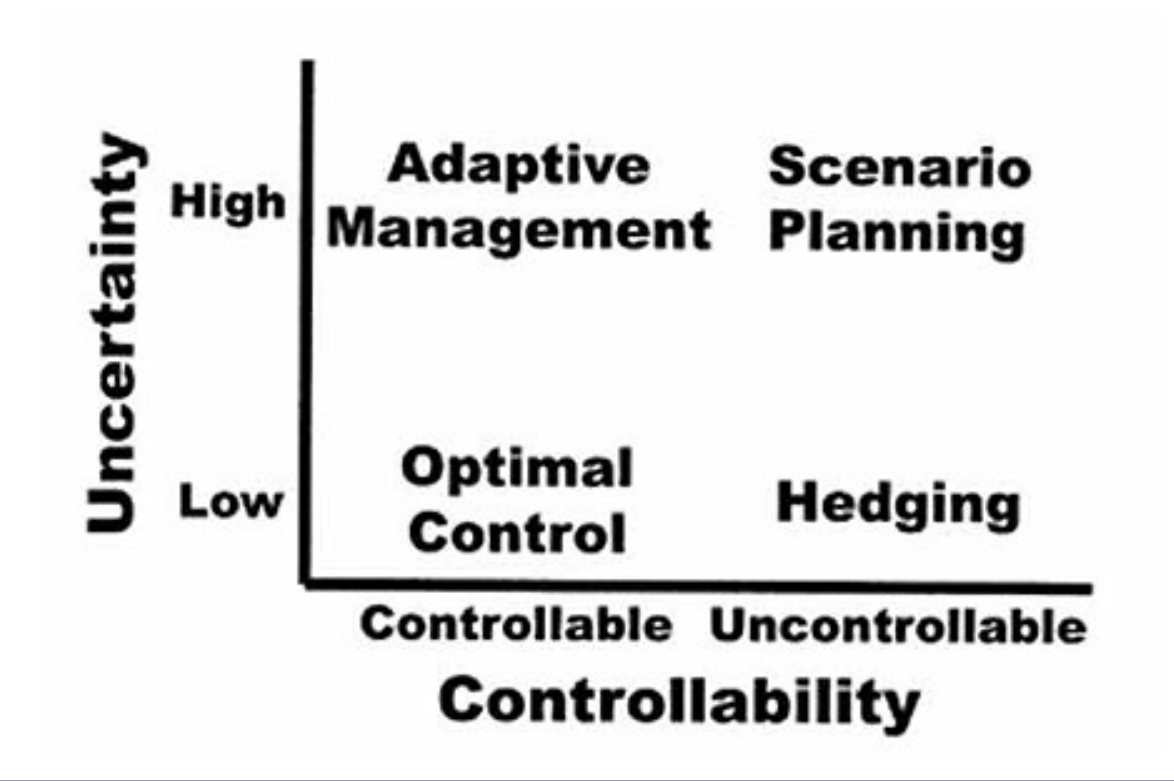
Fig. 1 . Scenario planning is most appropriate under conditions of high uncertainty and when the forces driving that uncertainty are largely uncontrollable (figure from Peterson et al. 2003 a